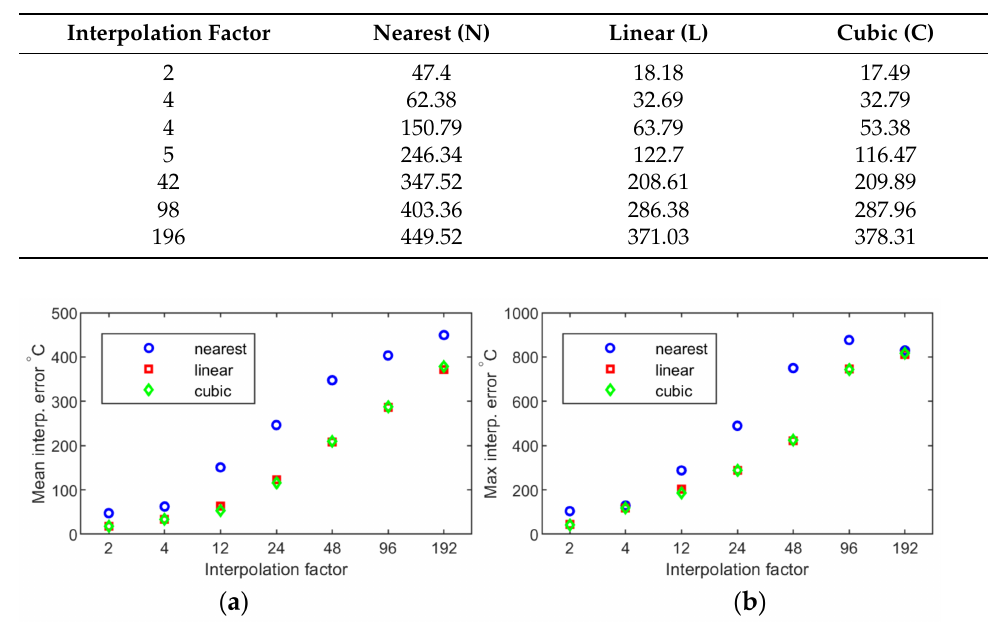
Figure 13. Comparison of similarity between the original IR sequence and the interpolate sequences: ( a ) mean error and ( b ) maximal